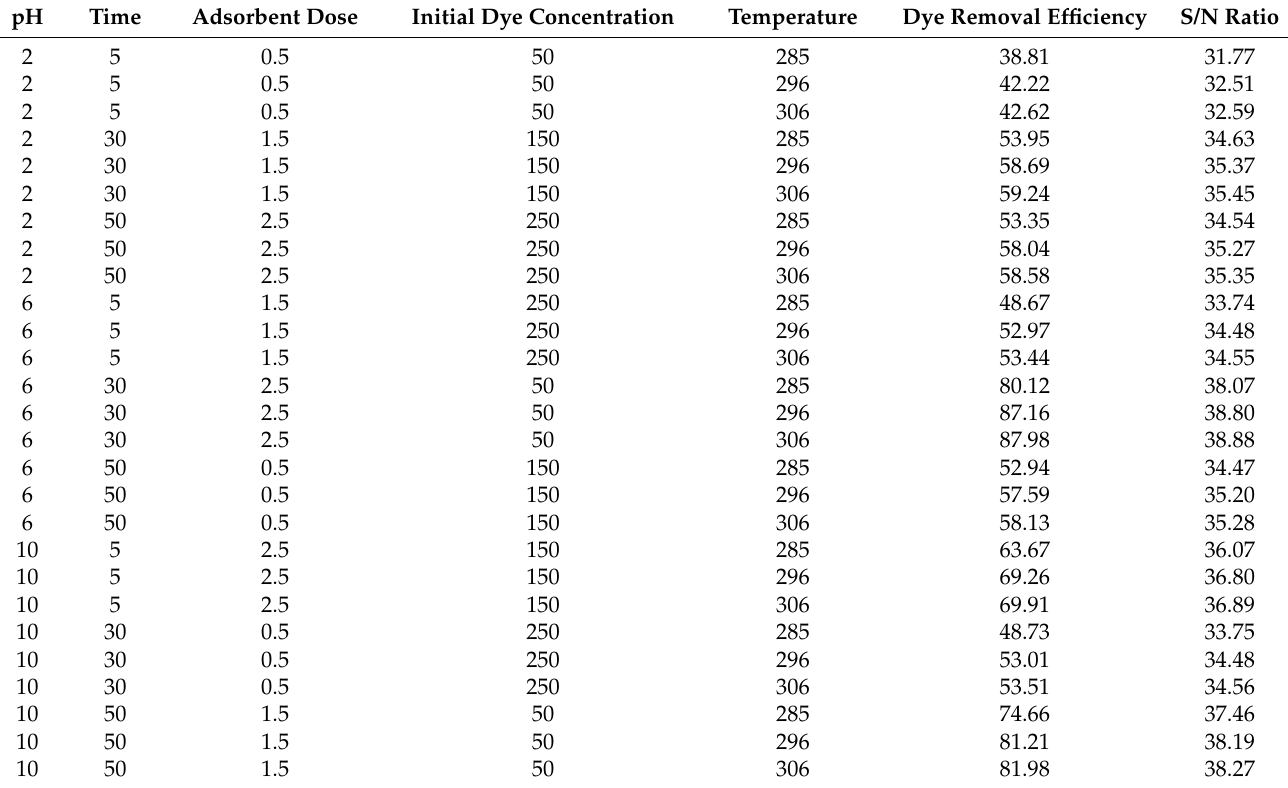
Table 2. Experimental layout of L27 orthogonal array and results obtained for removal efficiency and S/N ratios.